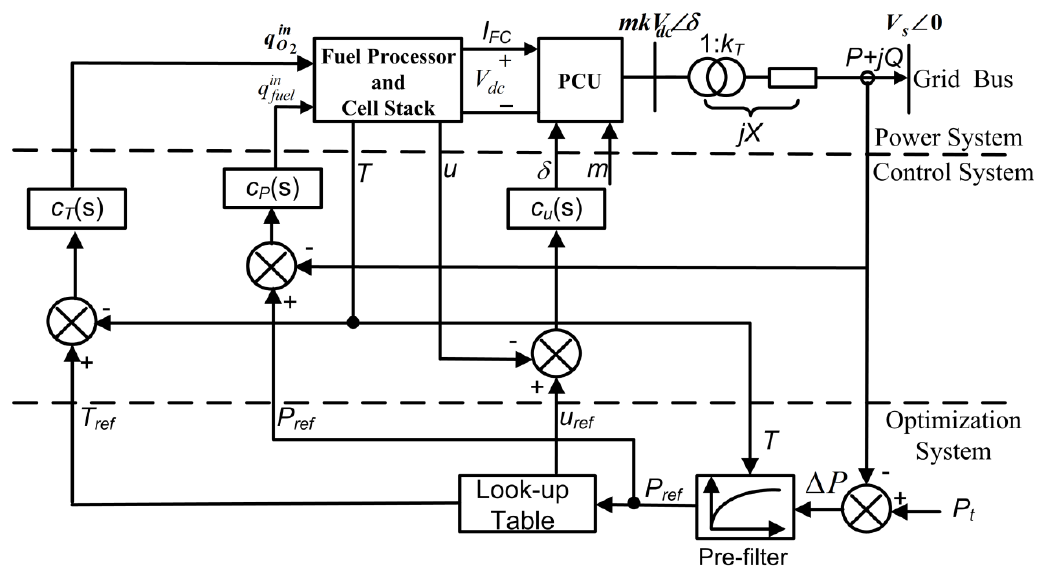
Figure 2. Schematic diagram of a grid-connected SOFC power plant and the overall load tracking control system for maximum electrical efficiency